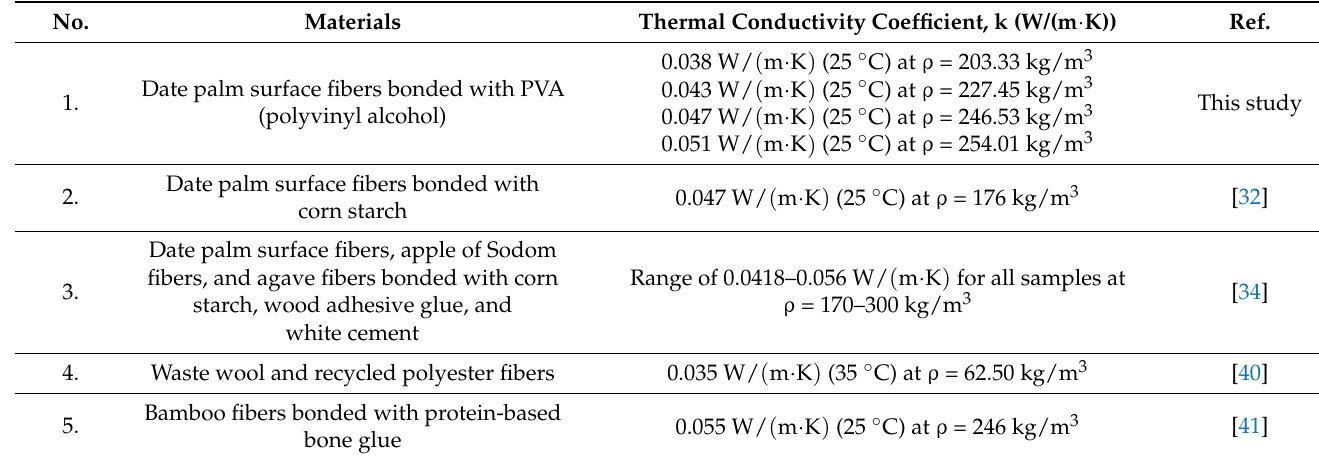
Table 2. Thermal conductivity coefficients of the fiber-based insulation composites.